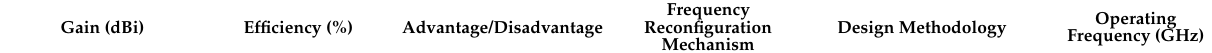
Table 4. The emergence of design of frequency reconfigurable UWB notch antenna.